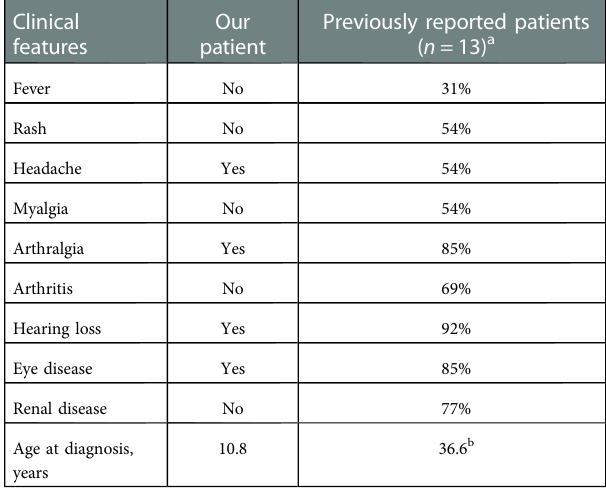
TABLE 1 Clinical features in our patient and previously reported patients with Muckle-Wells syndrome with the NLRP3 p.Glu313Lys variant. Clinical features